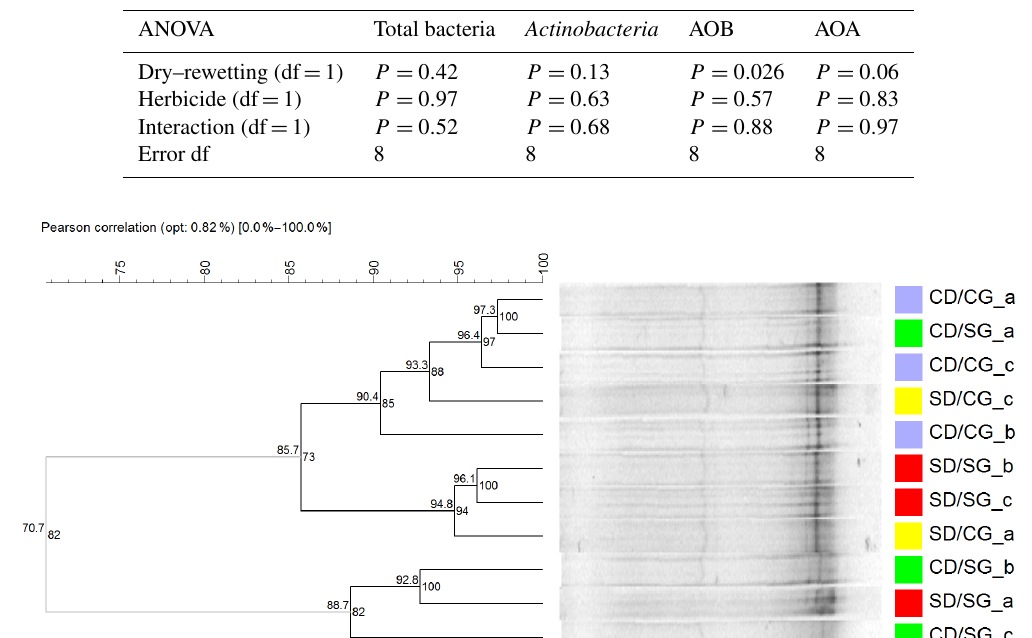
Table 2. Two-way ANOVA of copy numbers for different indicator genes. The P values indicated for the main effects of herbicide and of dry–rewetting disturbances correspond to the model without interaction as no significance ( P > 0 . 05) was observed for this term. df: degrees of freedom.